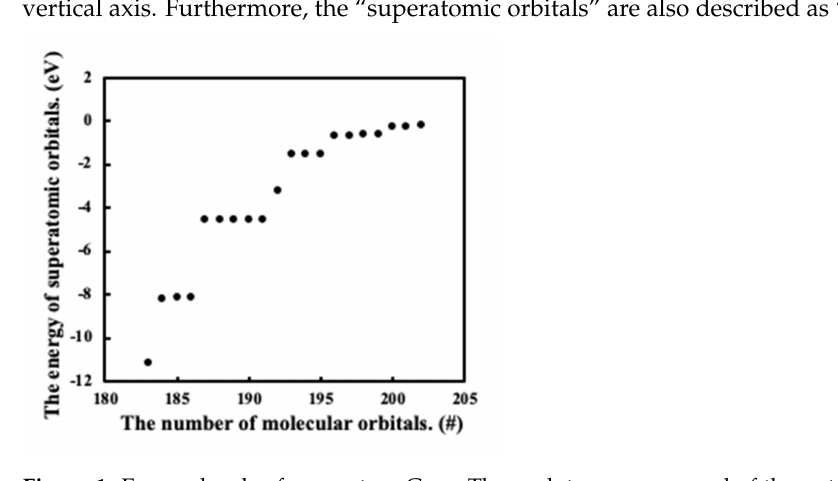
Figure 1. Energy levels of superatom Ga 13 . These plots are composed of the outer shell electrons from #183 to #202.